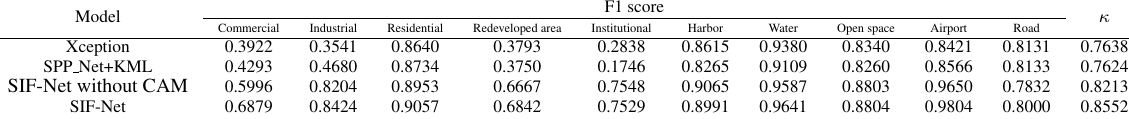
Table 1. Evaluation for experiment of four methods on CSU-RSISC10